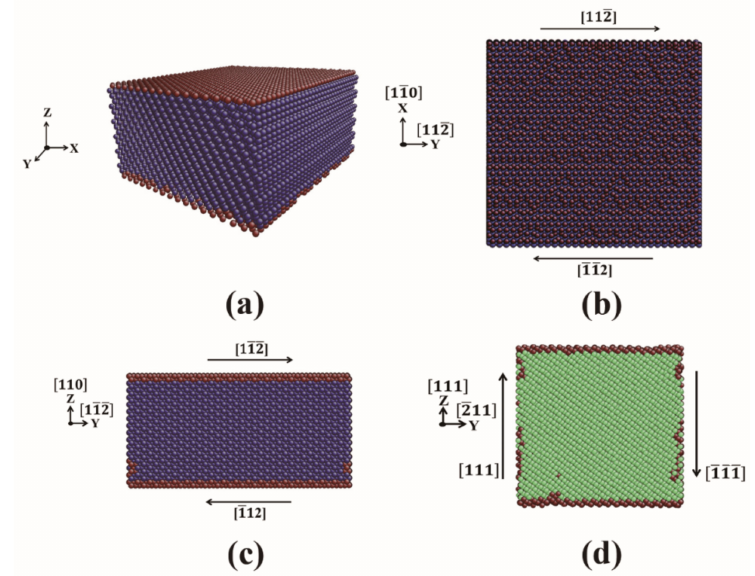
Figure 2. Shear deformations applied on the films. The colors denote the local crystal structure: green, body-centered cubic (bcc); dark blue, face-centered cubic (fcc); red, unknown. ( a ) Sketch of film 1 as an example for the modelling; ( b ) (111) fcc plane (surface) of film 1, the shear deformation is applied in this plane along the [112] fcc direction; ( c ) (111) fcc plane of film 2, the shear deformation is applied in this plane along the [112] fcc direction; ( d ) (011 ) bcc plane of film 3. The shear deformation is applied in the (211) bcc plane along the [111] bcc direction.